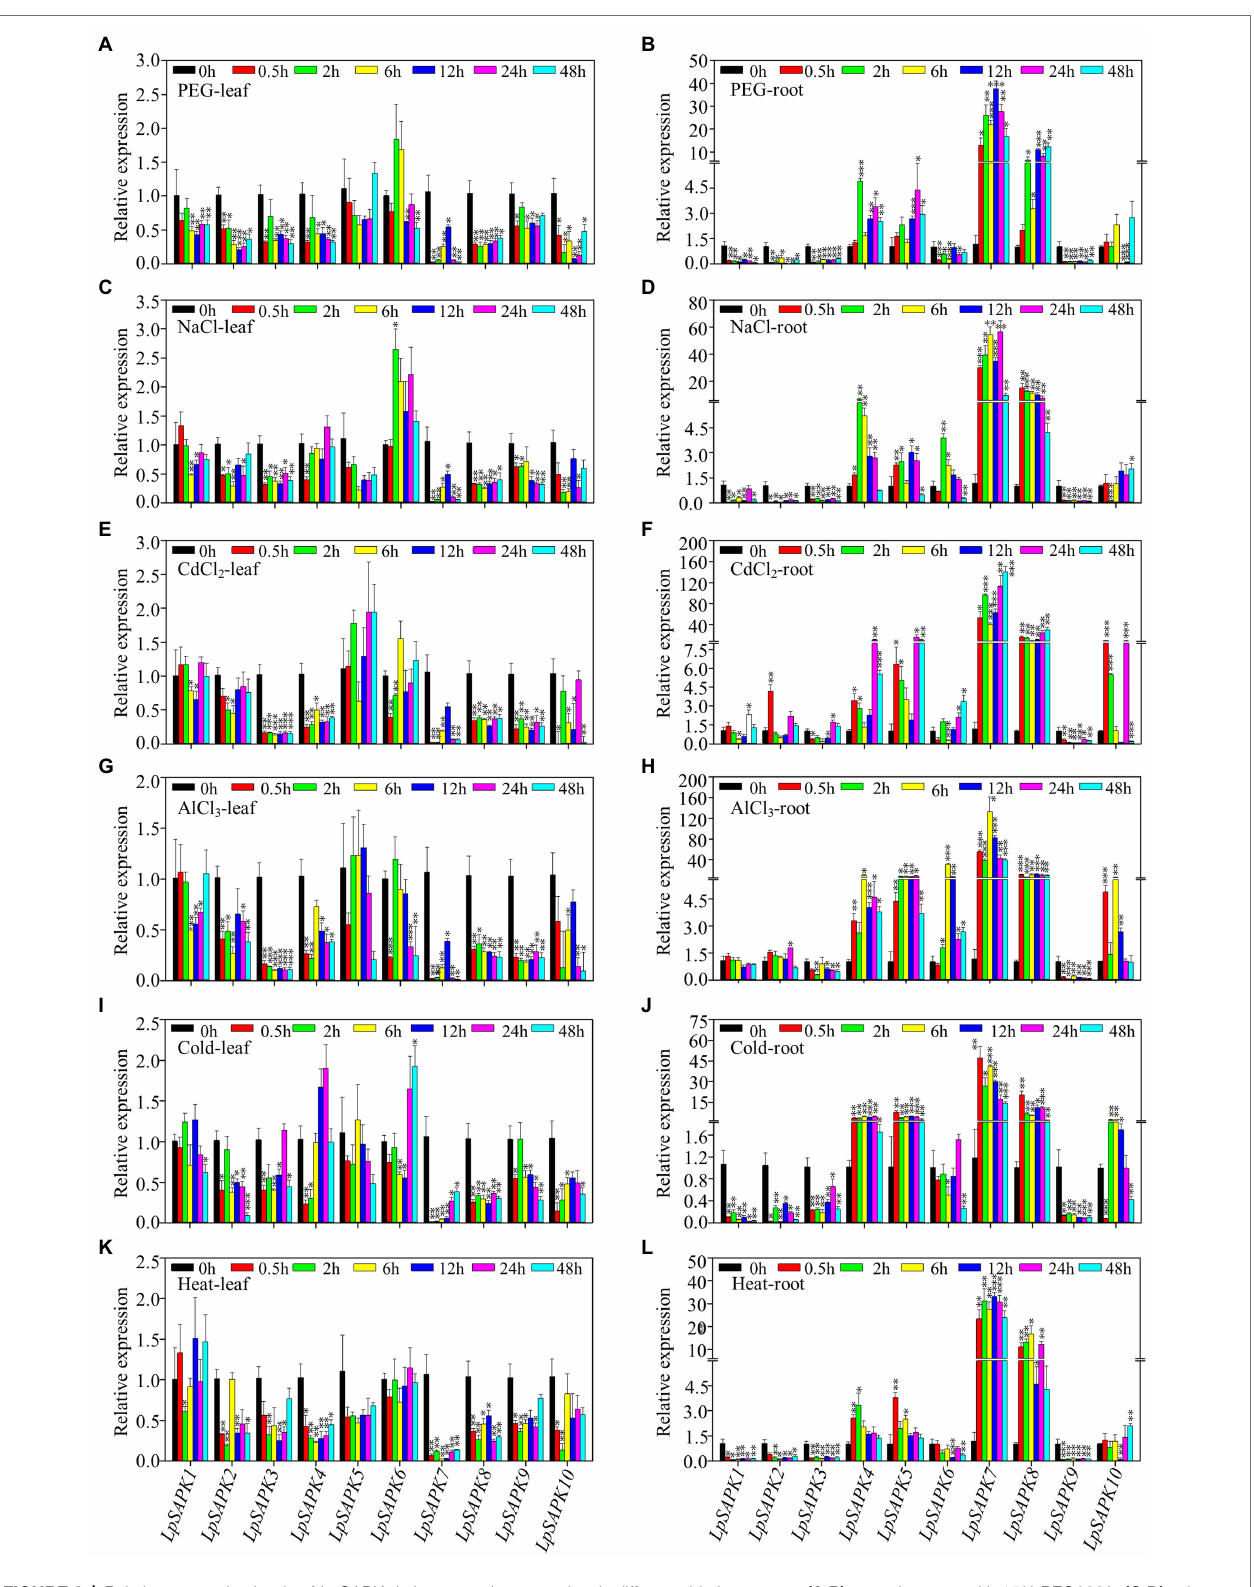
FIGURE 6 | Relative expression levels of LpSAPKs in leaves and roots under six different abiotic stresses. (A,B) osmotic stress with 15% PEG6000; (C,D) salt stress; (E–H) heavy mental stress (200 μ m CdCl 2 and 1.6 Mm AlCl 3 ); (I,J) cold stress (4 ° C); (K,L) heat stress (38 ° C). Data are means ± SE ( n = 4). *, **, and *** above the bars represents significant difference compared to the values at 0 h at p ≤ 0.05, 0.01, and 0.001,